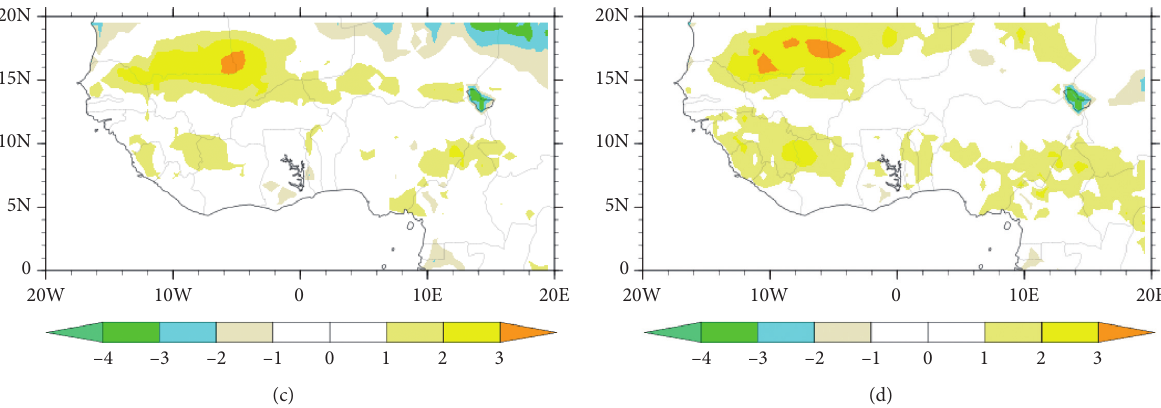
Figure 3: Spatial bias of average 2m surface temperature ( ° C) for July 16 th –Sept 29 th , 2012. (a) Noah-MP groundwater